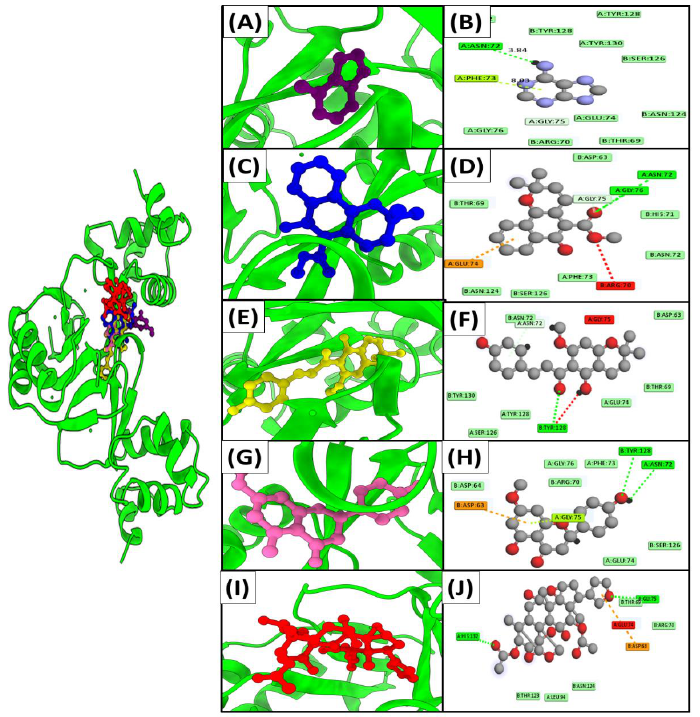
Figure 3. Interaction mechanisms and binding modes of novel FUR protein inhibitors. A 3D close view into the binding mode of ( A ) Adenine, ( C ) Mollugin, ( E ) Xanthohumol C, ( G ) Sakuranetin, and ( I ) Toosendanin. 2D interaction analysis of ( B ) Adenine, ( D ) Mollugin, ( F ) Xanthohumol C, ( H ) Sa- kuranetin, and ( J ) Toosendanin. Similarly, Adenine, Mollugin, Xanthohumol C, Sakuranetin, and Toosendanin have been found to bind through significant hydrogen bonds in UDP protein, with binding scores of −1 1.6 kcal/mol, −1 9.8 kcal/mol, −1 5.3 kcal/mol, −1 4.9 kcal/mol, and −1 7.6 kcal/mol, respectively. As illustrated in Table 3 and Figure 4, all of the active site ’ s critical residues function as electron donors in the development of a H-bond network